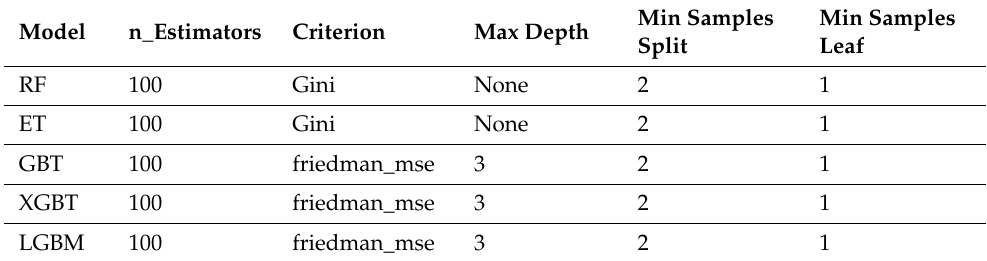
Table 1. Hyperparameters values for each